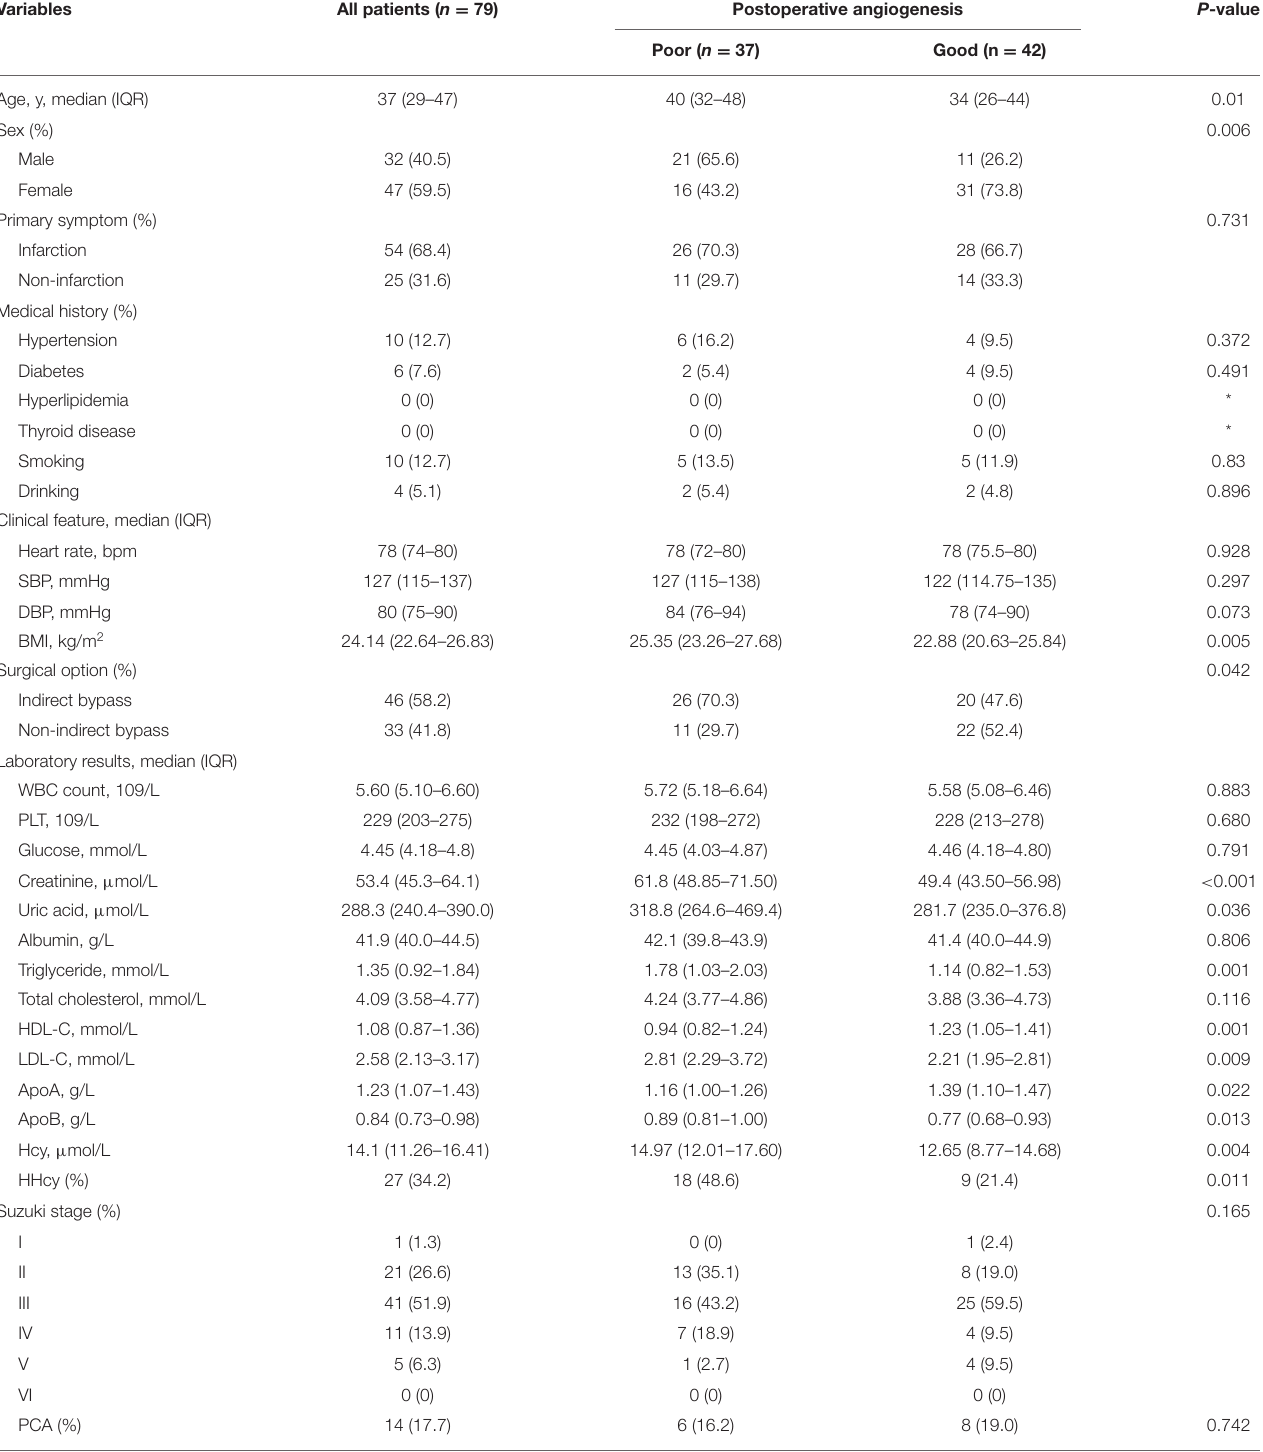
TABLE 1 | Baseline characteristics and laboratory examinations of postoperative